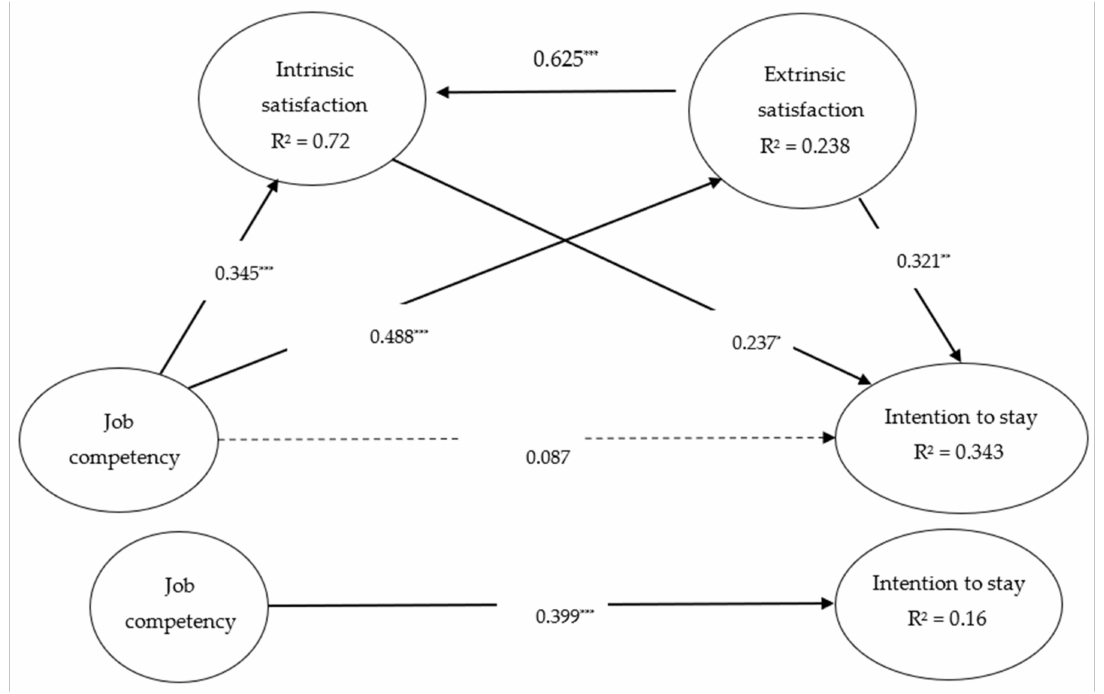
Figure 1. Theoretical model. Note: * p < 0.05; ** p < 0.01; *** p <